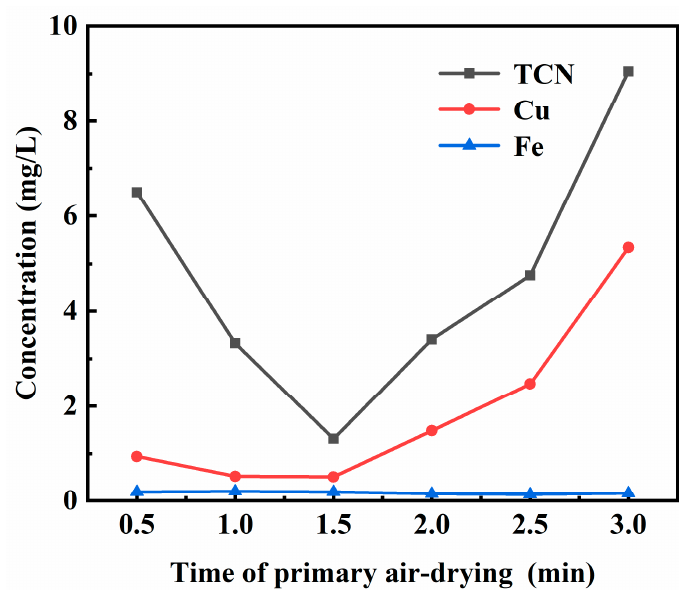
Figure 2. Effect of primary air-drying time on the leaching toxicity of backwashed cyanide tailings.